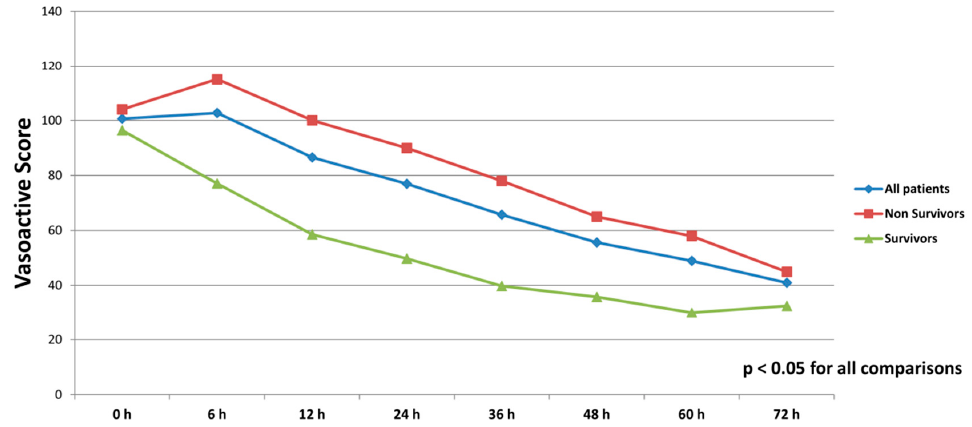
Figure 2. Course of vasoactive score (dobutamine dose ( µ g/kg/min) + 100 × epinephrine dose ( µ g/kg/min) + 100 × norepinephrine dose ( µ g/kg/min)) in all patients, survivors and non-survivors within 72 h after initiation of biventricular support.